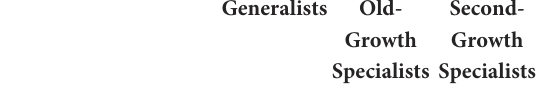
TABLE 3 Tree specialist groups by dispersal mode and seed size.